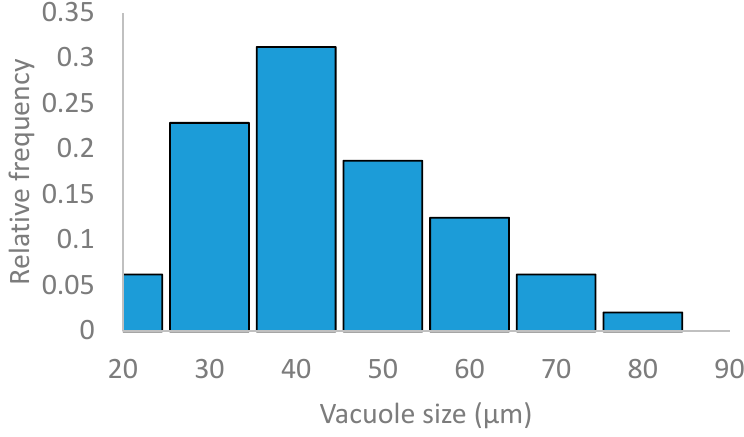
Figure 9. Vacuole size frequency distribution of beet pulp raw material.